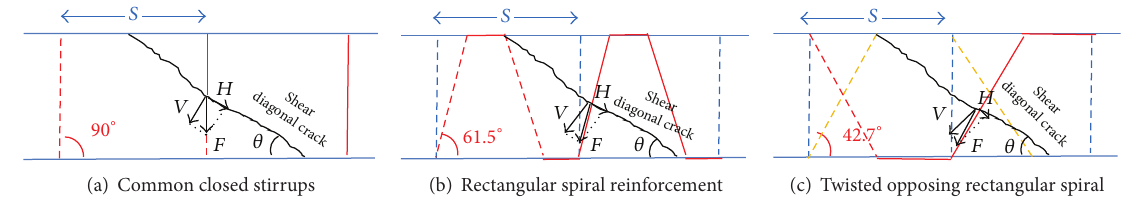
Figure 1: Contribution of the spiral reinforcement on the shear